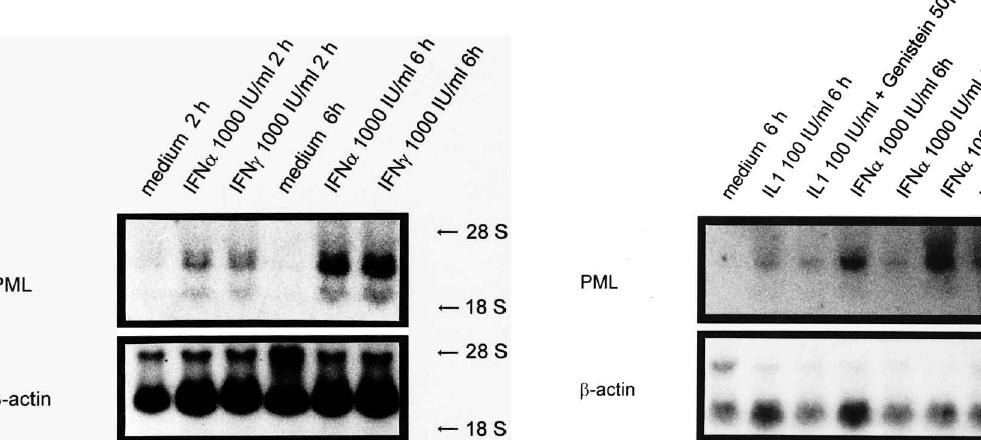
FIG. 3. Northern blot analysis of PML-specific mRNA levels from IFN- a and IFN- g treated HL60 cells. HL60 cells were treated with IFN- a (1000IU/ml) or IFN- g (1000U/ml) for the indicated time or were left untreated. Northern blotting was performed as described above. Densitometric scanning revealed a 2.5-fold and 1.9-fold induction of PML-mRNA levels upon incubation for 2h with IFN- a (1000IU/ml) and IFN- g (1000IU/ml), respectively. Incubation for 6h with IFN- a (1000IU/ml) and IFN- g (1000IU/ml) showed a 25.4-fold and a 27.4-fold induction of PML-specific transcript levels.